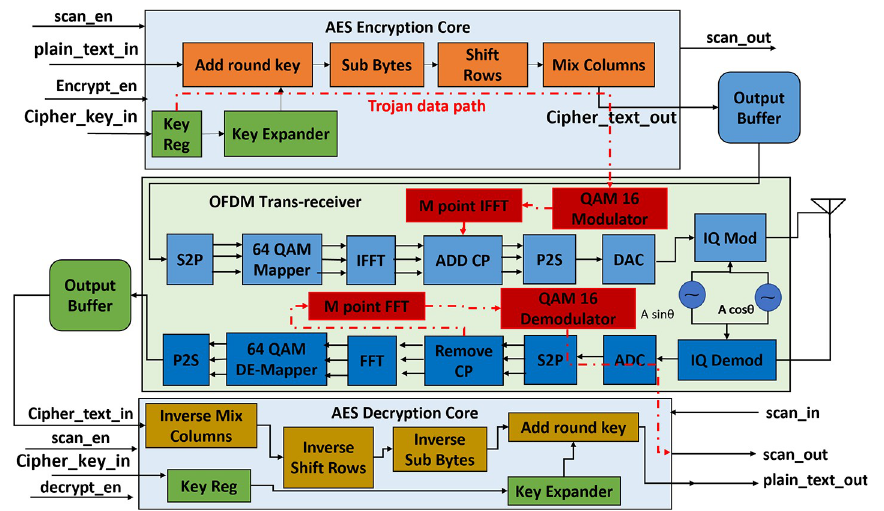
Fig 10. Detailed block diagram of trojan infested IC.